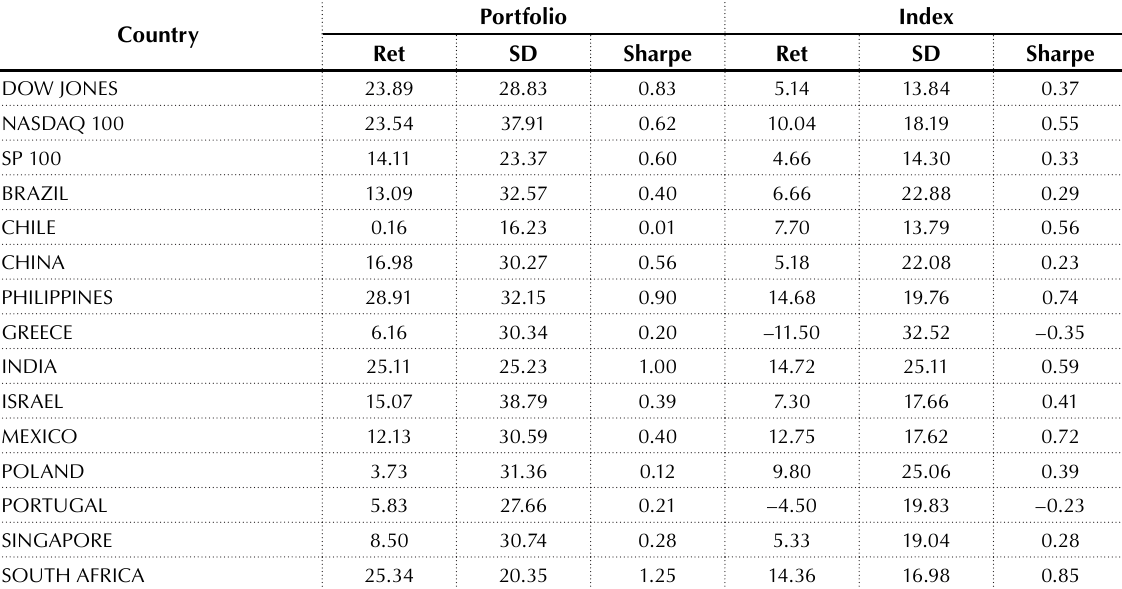
Table 7. Performance of mean-variance optimized portfolios, excess returns Panel A. Performance statistics